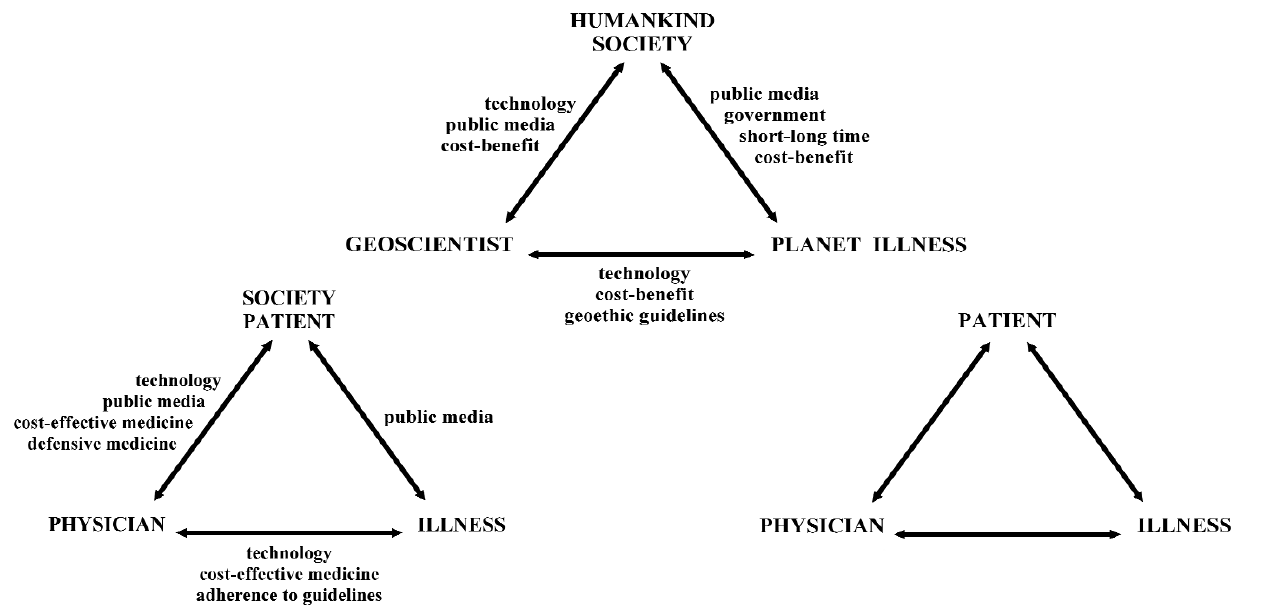
Figure 1. Factors affecting the Hippocratic triangle [inspired by Antoniou et al. 2010], in medicine (physician, illness, patient/society) and the geological sciences (geoscientists, Planet ‘illness’ – hazards, human imprinting – and society). Bottom right: The early relationships according to Hippocrates. Bottom left: In medicine today. Top: The geoscientists